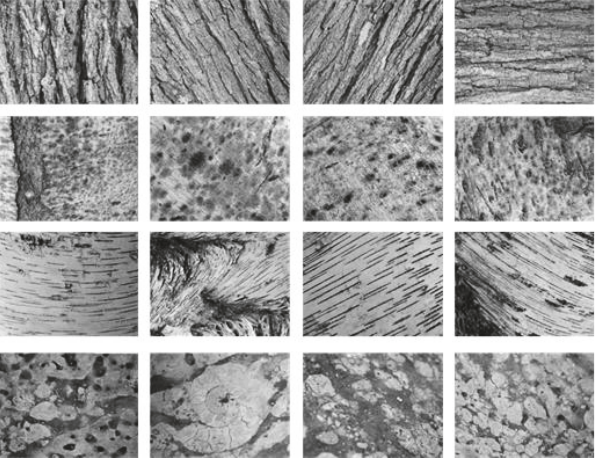
Figure 11: TDB data set T D